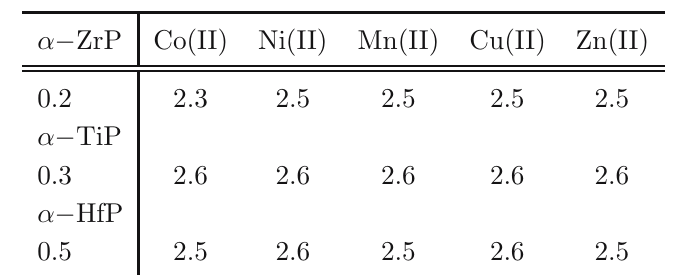
Table 3 Specific surface